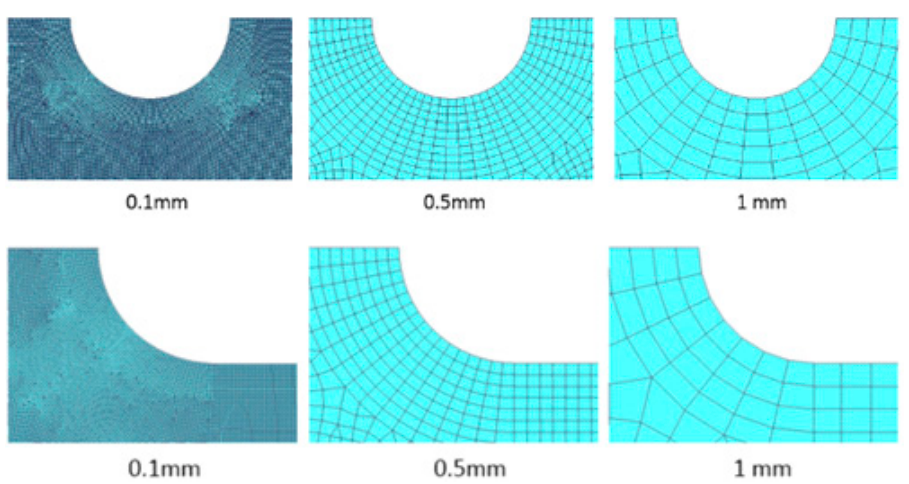
Figure 3. Element network on a plate ( top ) with a opposite semicircular groove under tensile load (K σ = 2.64, σ max = 377.7 MPa [10,12]) and on a stepped plate ( bottom ) under tensile load (K σ = 1.9, σ max = 380 MPa [10,13]).